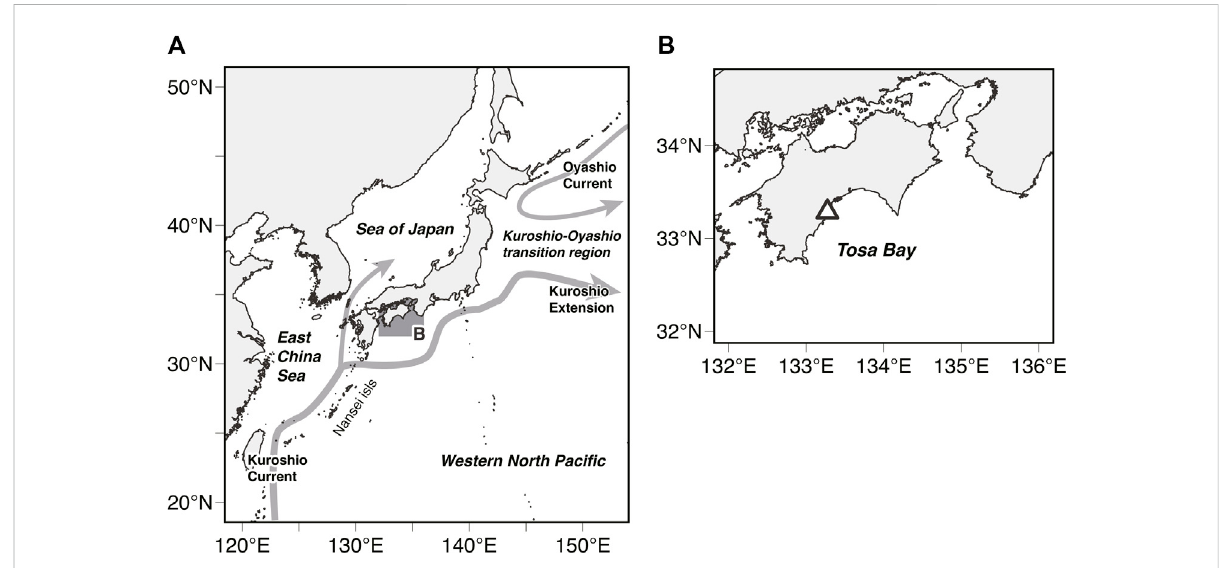
FIGURE 1 (A) Map of the western North Paci fi c Ocean showing the study area (shaded area). Schematic of the near-surface currents around Japan: Kuroshio Current, Kuroshio Extension, and Oyashio Current (gray arrows) (B) The white triangle represents the release location of tagged Paci fi c Blue fi n Tuna